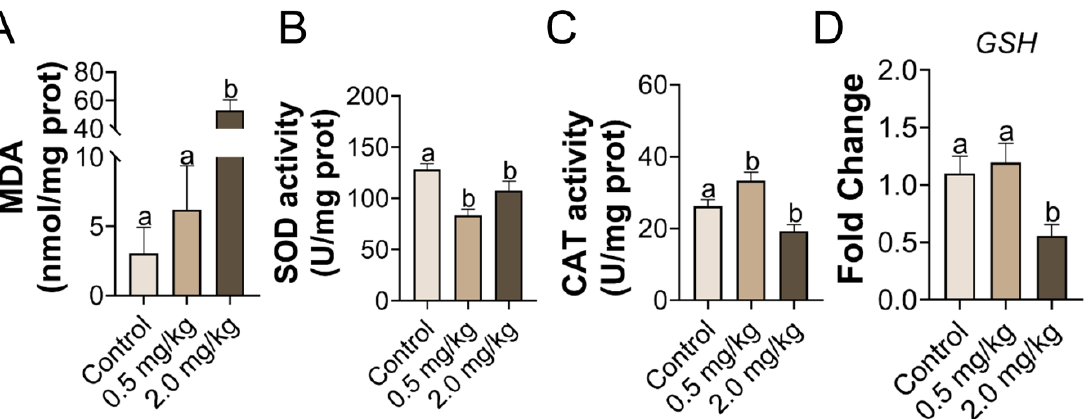
Figure 3. PS-MPs cause oxidative stress in the ovary. ( A ) The concentration of MDA, the antioxidant activity within SOD, and CAT ( B , C ). ( D ) The comparative mRNA expression of GSH in the ovary was analyzed. The information was presented as the mean ± SD. Different letters indicate significance. n = 5 per group.